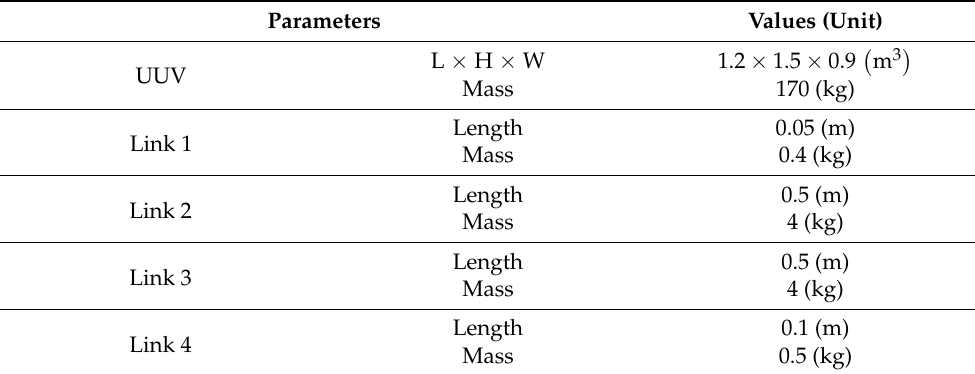
Table 1. Parameters of UUV and MM